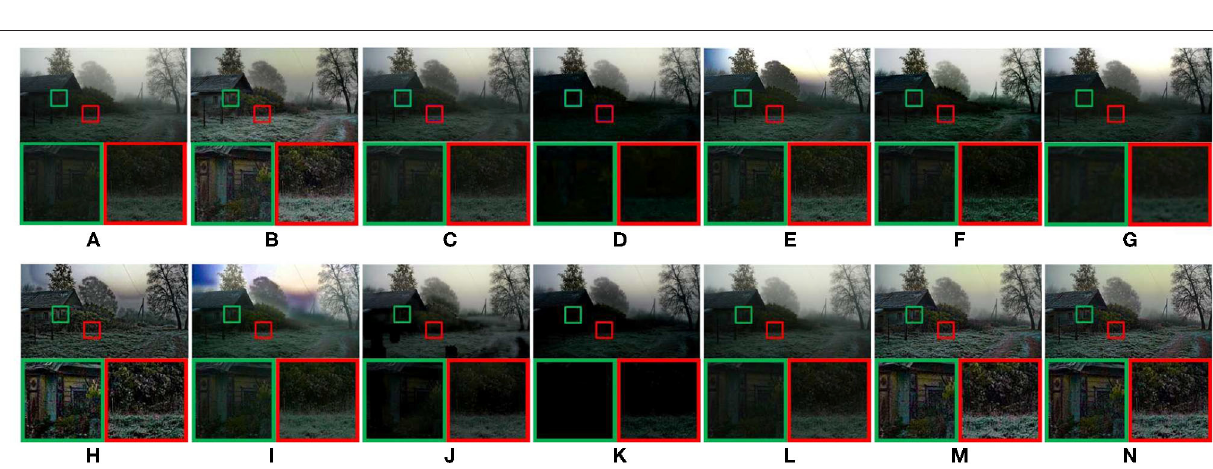
FIGURE 5 | Real-world natural image. (A) Represents the original foggy image. (B–N) Represent foggy-free images processed by AMEF, CAP, CO, DCP, DEFADE, GPR, MAMF, OTE, WCD, DehazeNet, FFA-Net, MIF, and the proposed method.